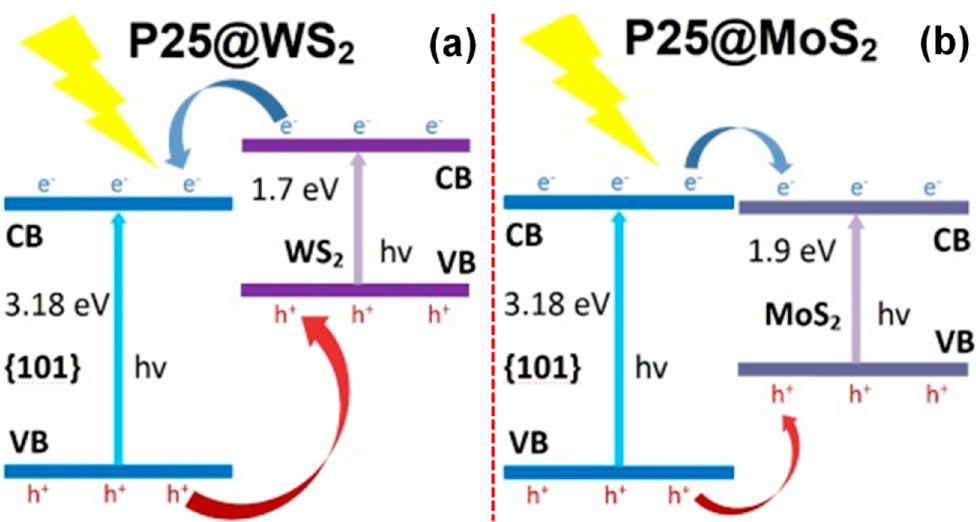
Figure 15. Photocatalytic charge transfer mechanism in ( a ) P25-TiO 2 /WS 2 and ( b ) P25-TiO 2 /MoS 2 (reproduced with permission from ref. [200]).